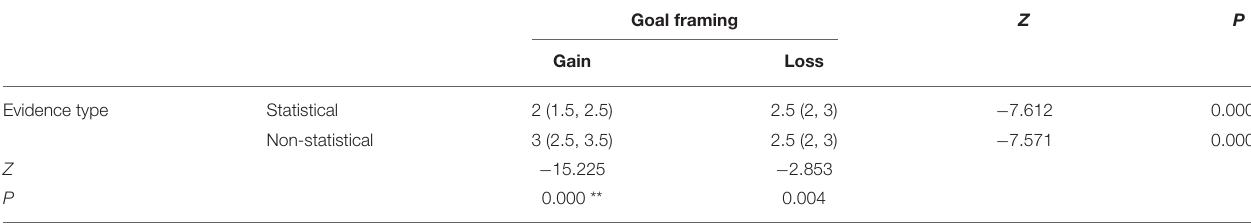
TABLE 4 | Persuasive effects of framed messages with different types of